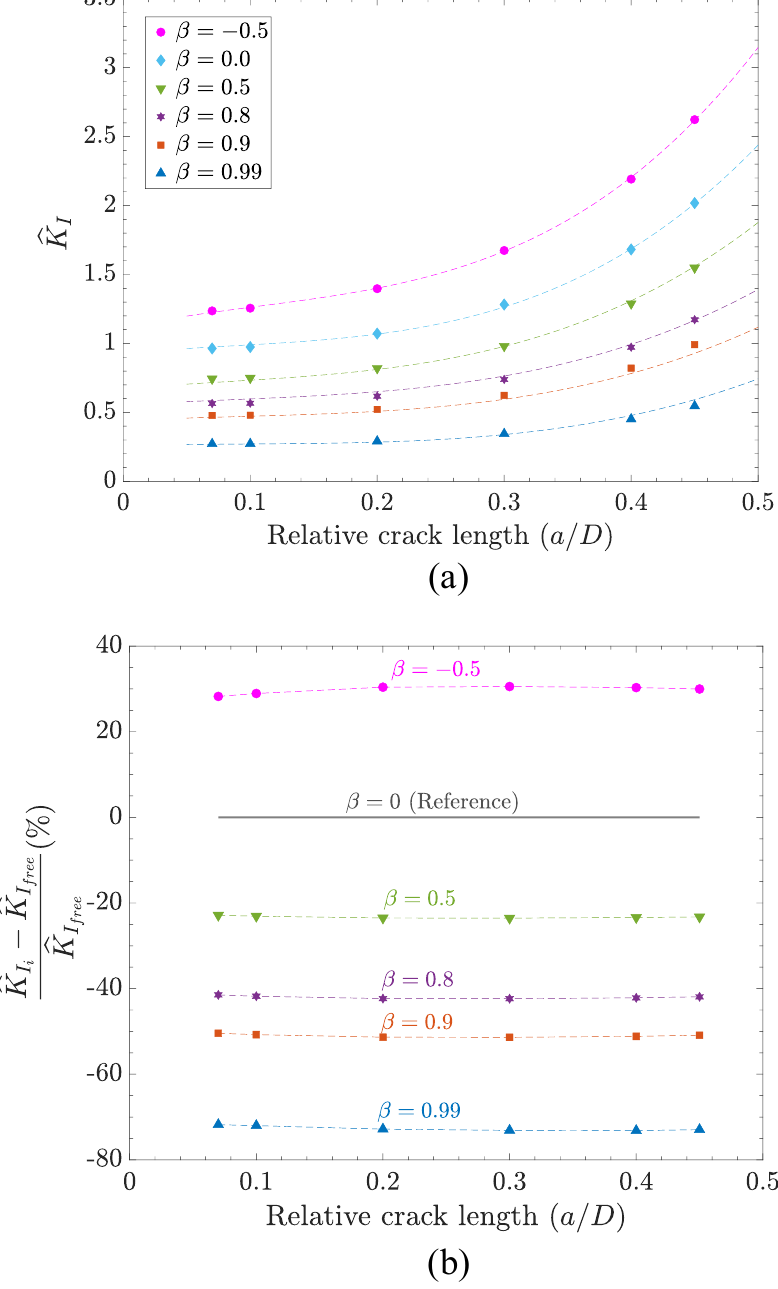
Figure 6. ( a ) Comparison of non-dimensional stress intensity factor of an orthotropic free fibre for different longitudinal/transverse stiffness ratios, β . The dots refer to the FEM results and the dashed lines indicate the fitting results. ( b ) Percentage of non-dimensional stress intensity factor changes of an orthotropic free fibre for different longitudinal/transverse stiffness ratio, β . The percentage change was calculated with respect to the model with β = 0 ( E 1 = E 2 ) as the